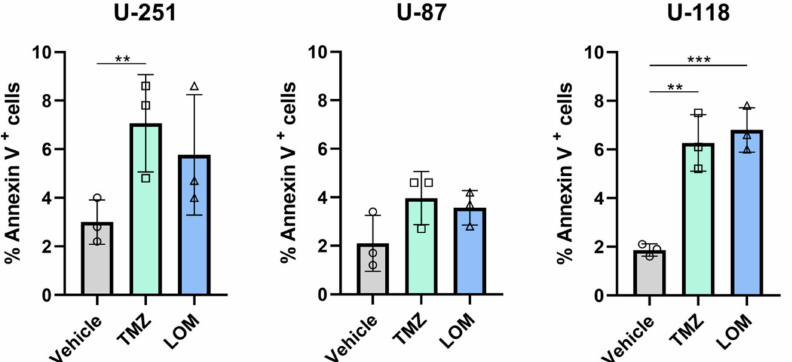
Figure 3. Treatment with TMZ or LOM increases the percentage of Annexin V-positive GBM cells. Cells were incubated with PE-labeled Annexin V for 15 min at RT, followed by several washes with Annexin V binding buffer. The percentage of Annexin V-positive cells was measured using a BD FACSCanto and analyzed using BD FACSDivaTM software. Biological triplicates are shown. ** p < 0.01, *** p < 0.001 vs vehicle (DMSO). Abbreviations: TMZ, temozolomide; LOM, lomustine.